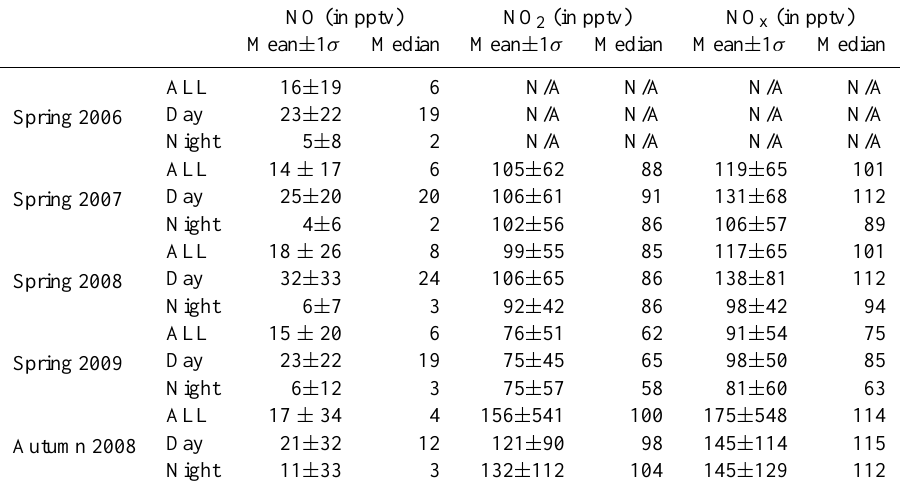
Table 1. Summary of NO x (=NO+NO 2 ) data for all four seasons presented in this paper. “Day” is defined as 5h after sunrise through 1h after sunset and “Night” is defined as 5h after sunset through 1h after sunrise (see Sect. 3.2). Note the large decline in NO x from spring 2007 and 2008 to spring 2009. Also note that mean NO x levels during the autumn campaign are significantly greater than during the spring